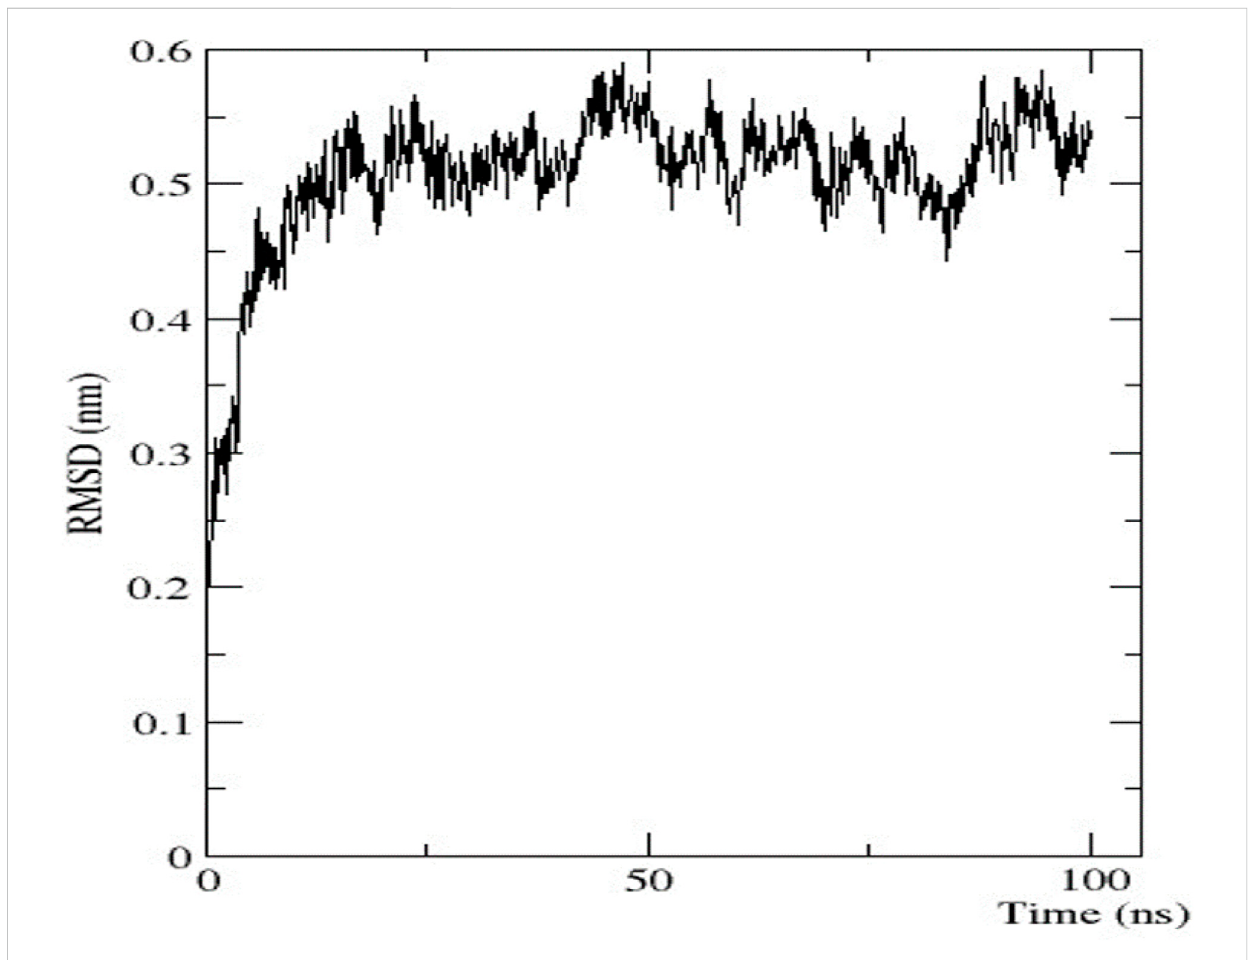
FIGURE 7 Graphical representation of